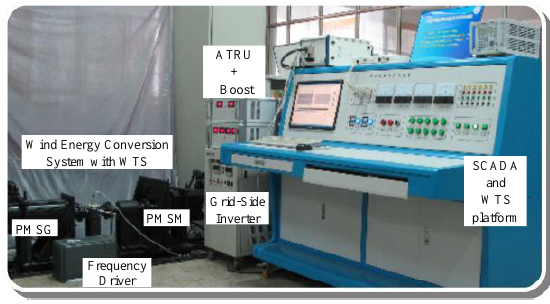
Figure 7. Laboratory test-rig setup.